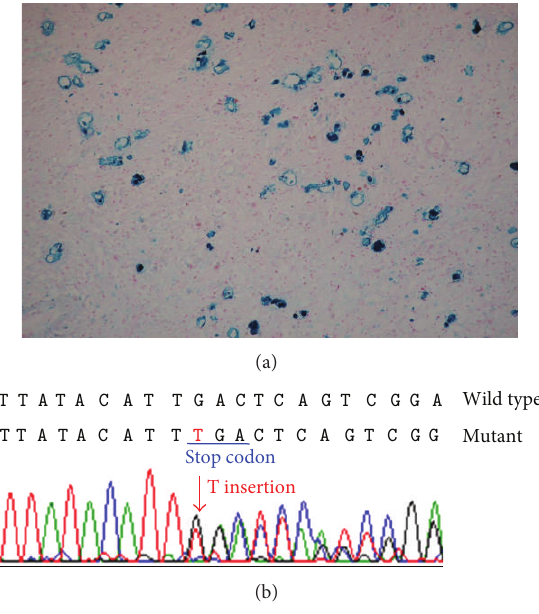
Figure 1: (a) The iron stain of the brain of our patient one showed diffuse granules with iron deposits in the globus pallidus. (b) Sequence chromatographs of exon 3 of PANK2 gene showed a heterozygous T insertion (c.1408insT) leading to a stop codon and therefore a truncation of the protein at position 350 (I349X).